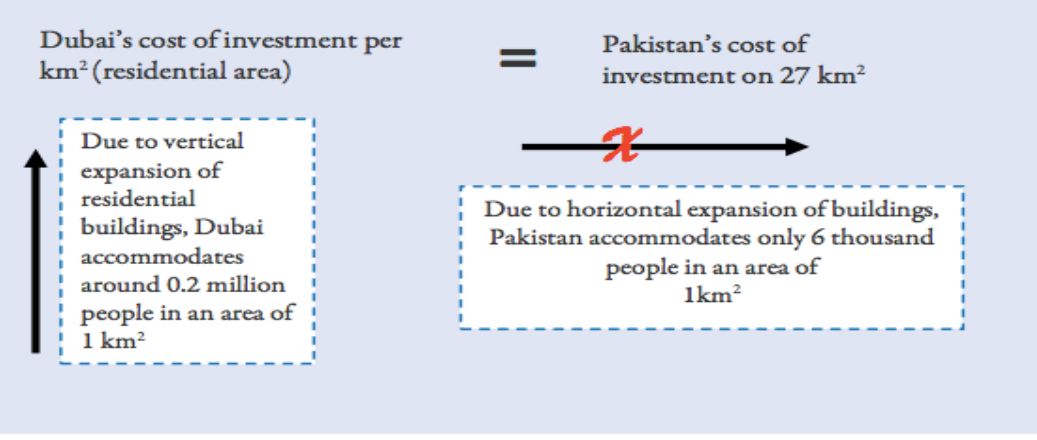
Figure 1. Population density comparison of Dubai and Pakistan (Planning Commission [34]) .